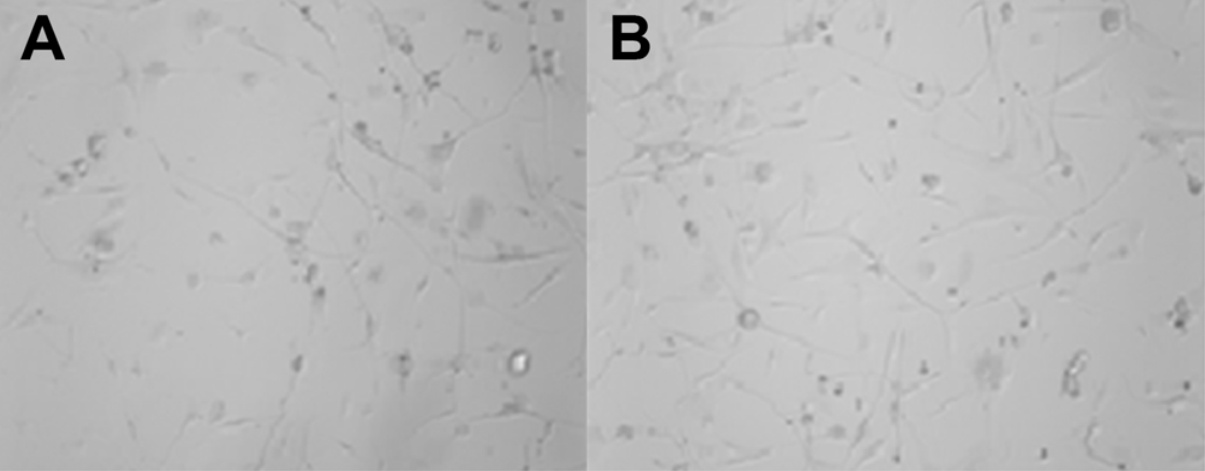
Fig 1. Microscographs of F3Y cells on PS or PAA. Cells were grown on either a standard polystyrene (PS) culture p late (left) or a polyacrylamide hydrogel (right) coated with collagen type I in 5% FBS in Advanced DMEM. (Under 10x magnification).